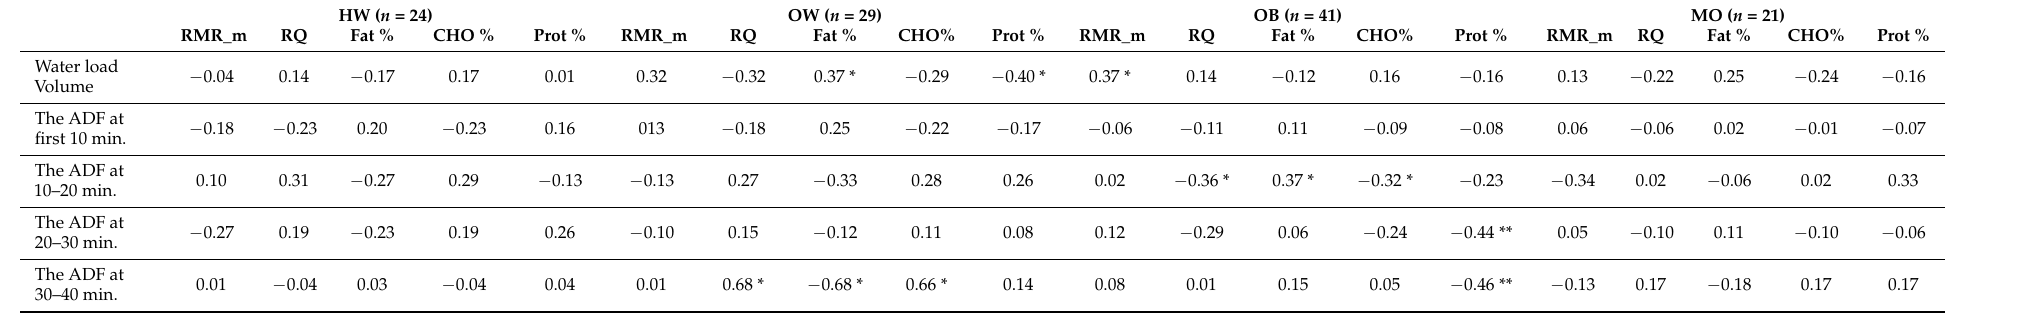
Table 5. Correlation between parameters of energy expenditure and gastric myoelectrical activity among subgroups, n = 115.